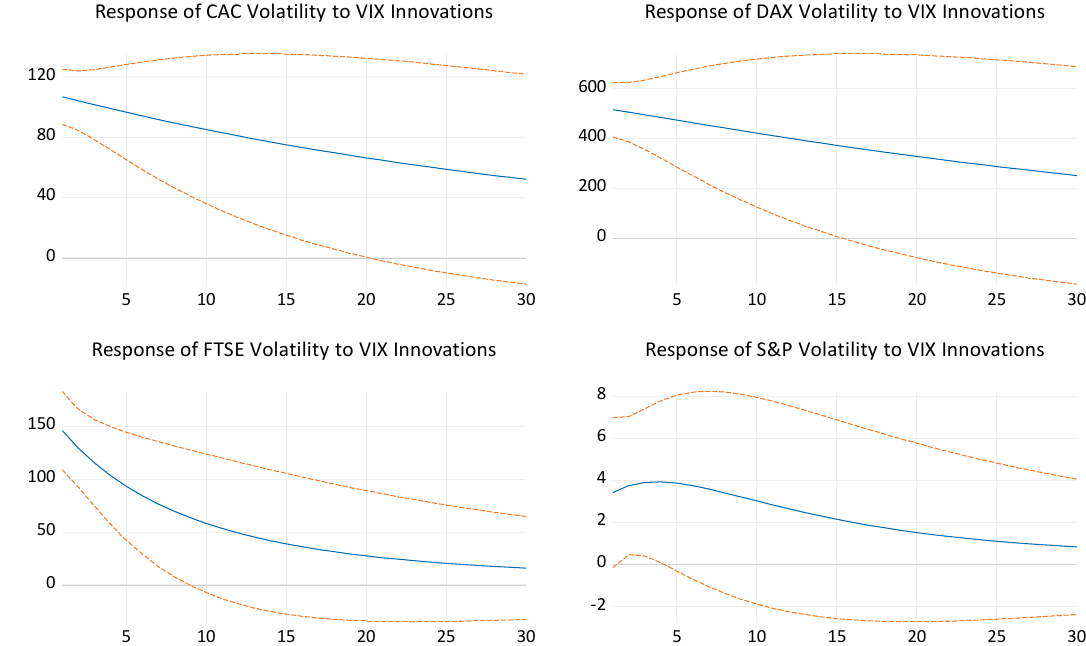
Figure 4. Responses of volatility in equity indices to structural innovations in the Chicago Board of Trade Volatility Index (VIX). Estimates and two standard deviation confidence band are in solid and dotted lines. SVAR lag order is one. Long-run identification restrictions are imposed. 24 June 2013–12 August 2015.